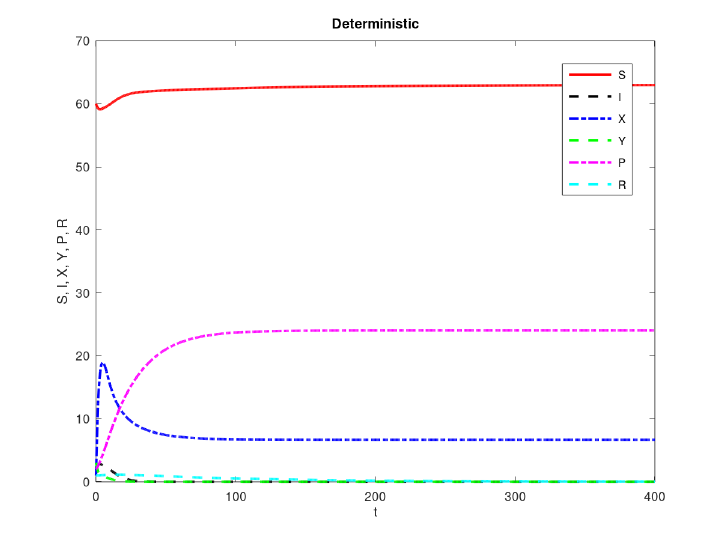
Figure 6. Plots for the virus plant model with saturations and no delays for the deterministic model. The final simulation was for the plant-virus model with both saturation and delays. All the parametrer values are given in Table 1 and the delays were τ 1 = 24 and τ 2 = 1. Figure 8 has the plot of the deterministic simulation. Figure 9 has the plots of the mean and of the mean +/ − one standard deviation for 1000 realizations for the stochastic simulations. On the left are the results for the SSA simulation, and the vertical lines represent the intervals (mean − 1 standard deviation, mean + 1 standard deviation). On the right are the plots for the stochastic differential equation run with σ equal to 0.025. The solid lines represent the mean values and the dashed lines the mean +/ − one standard deviation.